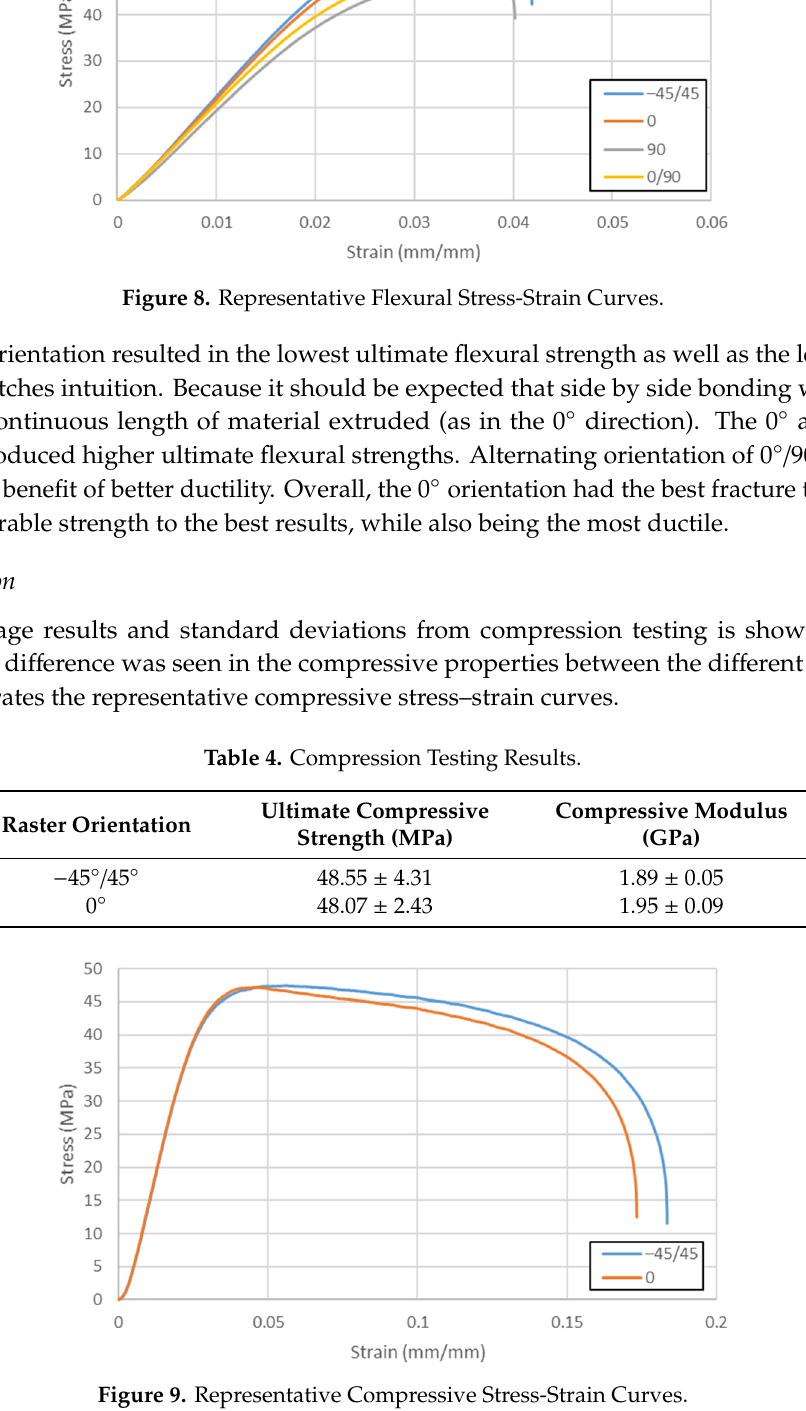
Table 5. Izod Impact Testing Results. Raster Orientation